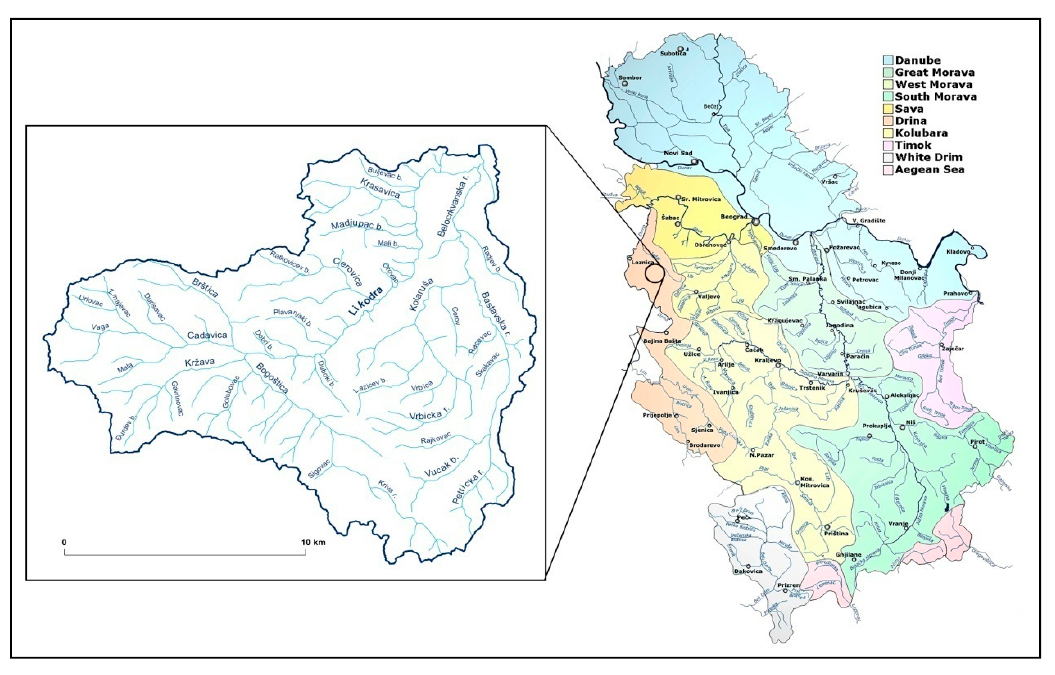
Figure 1. Geographical location of the Likodra basin in Serbia (1:1.500,000 scale map)